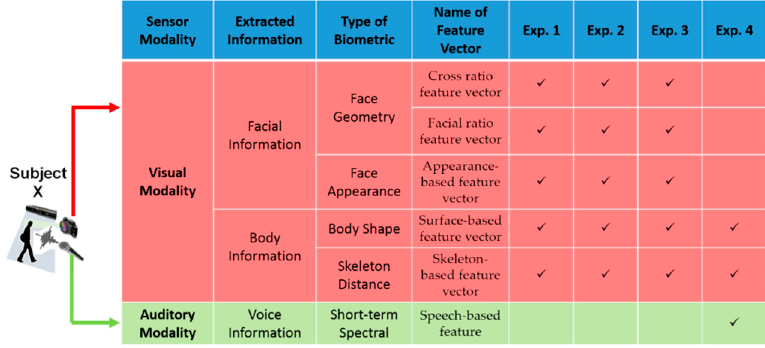
Figure 10. The Biometrics that have been discussed in the four